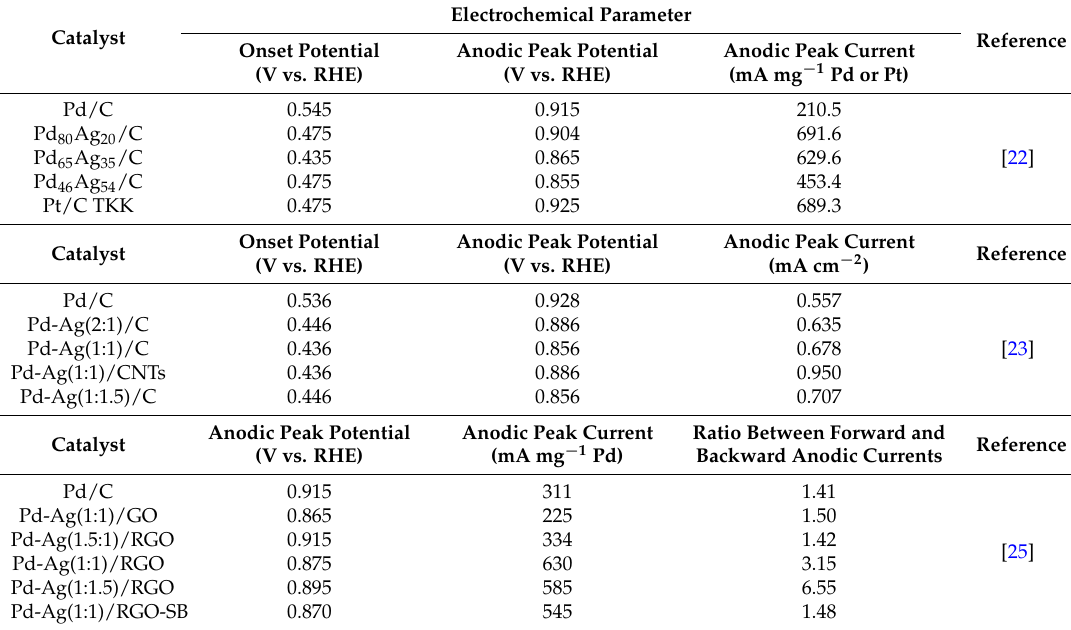
Table 2. Electrochemical properties of Pd-Ag catalysts supported on different carbon materials. Electrochemical Catalyst